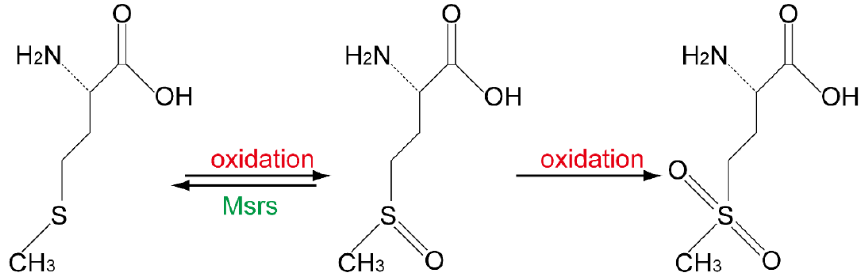
Figure 1. Methionine residue can be oxidized into methionine sulfoxide by, e.g., ROS and further oxidized into methionine sulfone by, e.g., performic acid; however, only methionine sulfoxide can be reduced back into methionine by methionine sulfoxide reductase (Msr) in a stereospecific man-